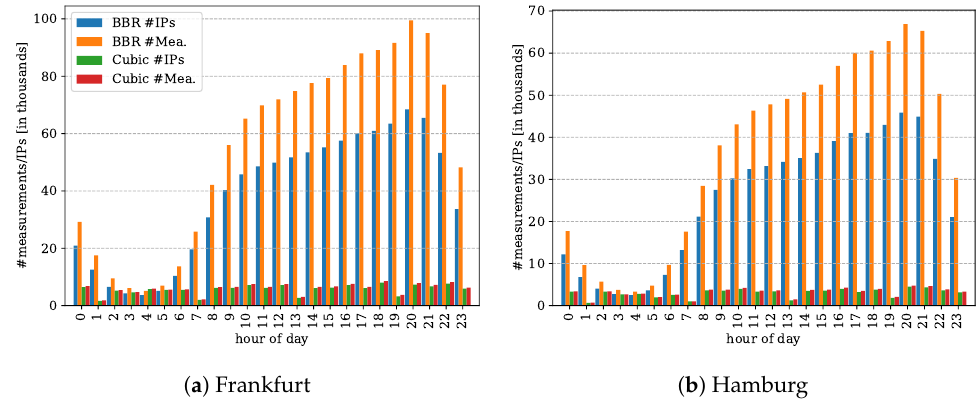
Figure 1. Frequency of measurements and active IPs in thousands per hour in August 2021: Mea- surements using TCP BBR follow a typical end-user pattern with a peak at the evening hours and little measurements after midnight. TCP Cubic shows a regular pattern during the day with periodic reductions at 1 a.m., 7 a.m., 1 p.m., and 7